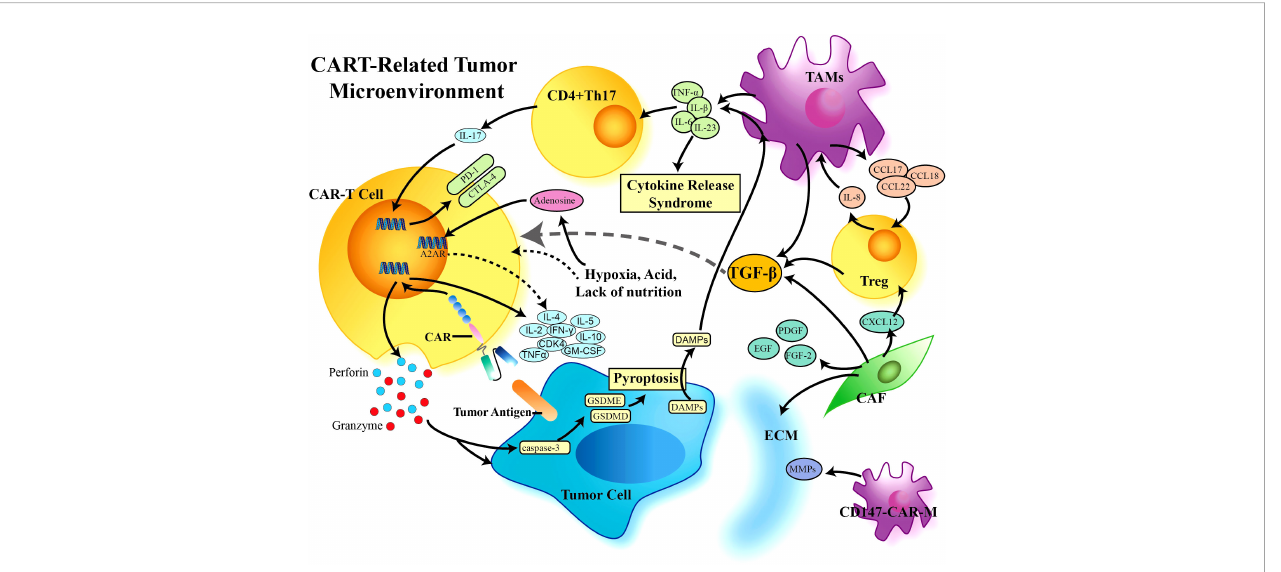
FIGURE 4 CAR-T cell-related tumor microenvironment (TME). A variety of cells participate in the formation of the tumor suppressive immune microenvironment, which limits the effect of CAR-T cells in solid tumors. TGF- b plays a central role in the TME, is produced by a variety of immunosuppressive cells, and can further negatively regulate the proliferation, differentiation, and activation of immune cells through downstream proteins and other factors. CAR, Chimeric Antigen Receptor; TGF- b , Transforming Growth Factor- b ; TAMs, Tumor Associated Macrophages; Treg, Regulor T-cell; CAF, Cancer Associated Fibroblasts; ECM, Extracellular Matrix; MMPs, Matrixmetalloproteinases; DAMPs, Damage Associated Molecular